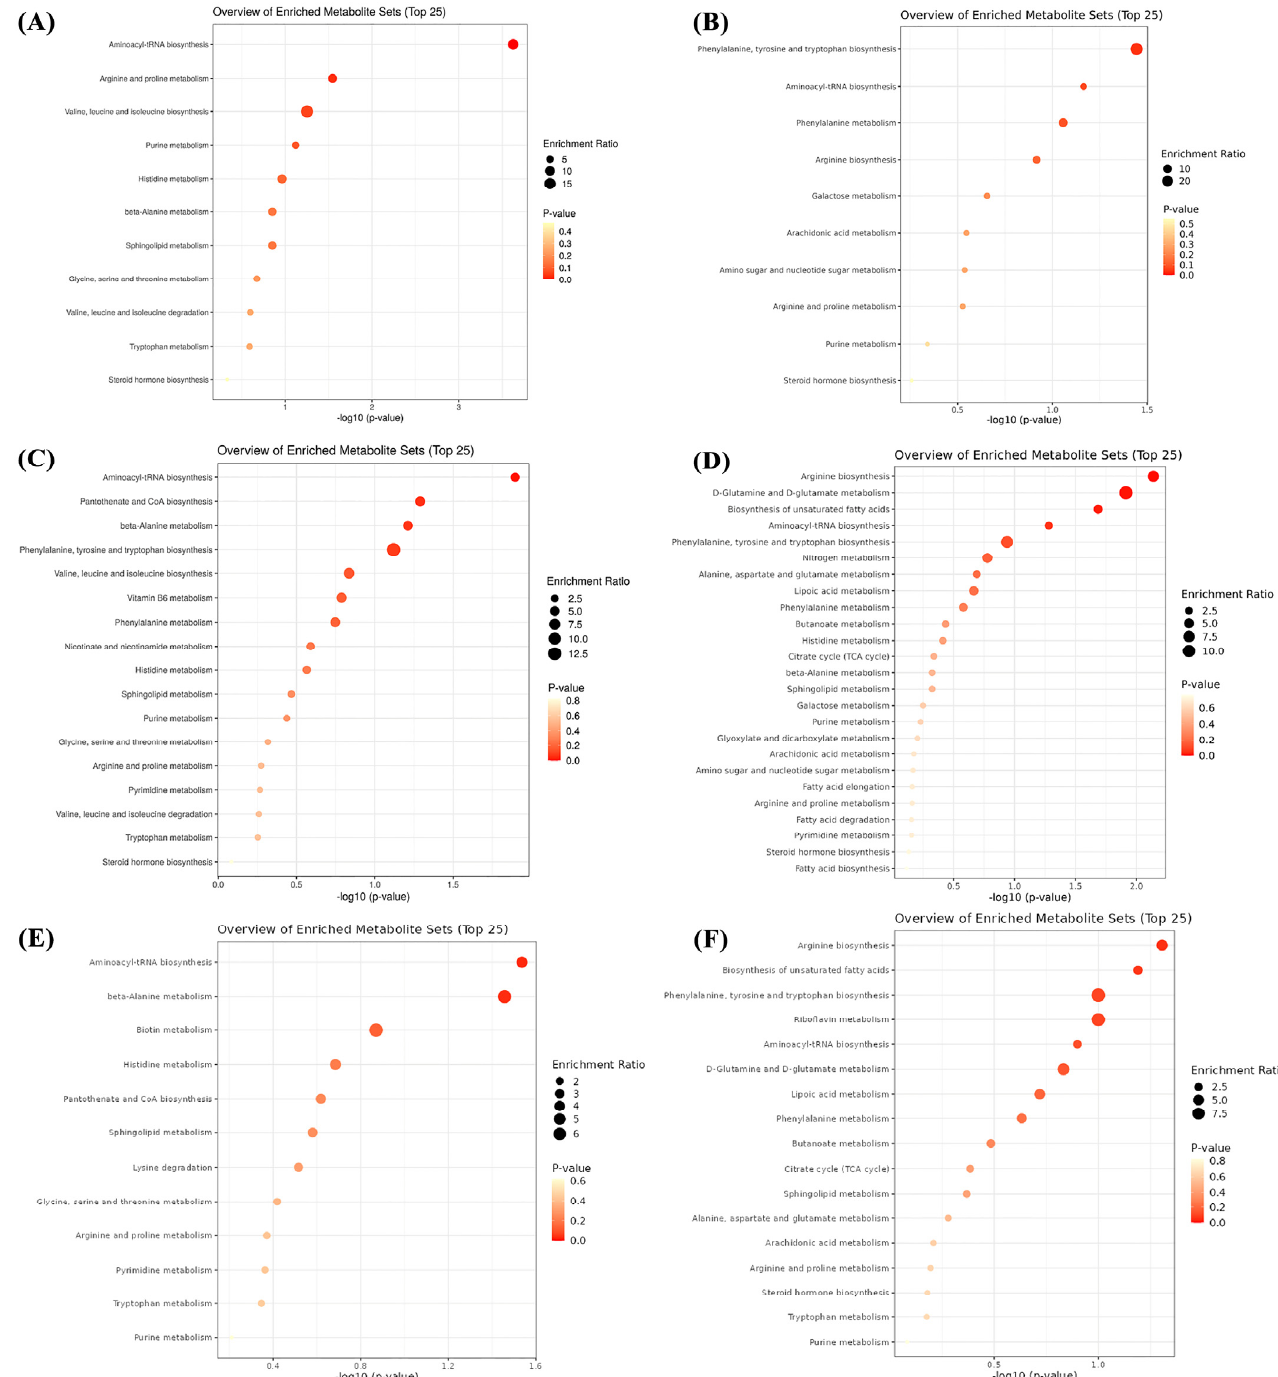
Figure 6. Metabolic pathway analysis of differential metabolites between FM and treatment groups. ( A , B ) metabolic pathways enriched under positive and negative ion models between FM and INSP groups, respectively; ( C , D ) metabolic pathways enriched under positive and negative ion models between FM and SNSP groups, respectively; ( E , F ) metabolic pathways enriched under positive and negative ion models between FM and NSP groups,